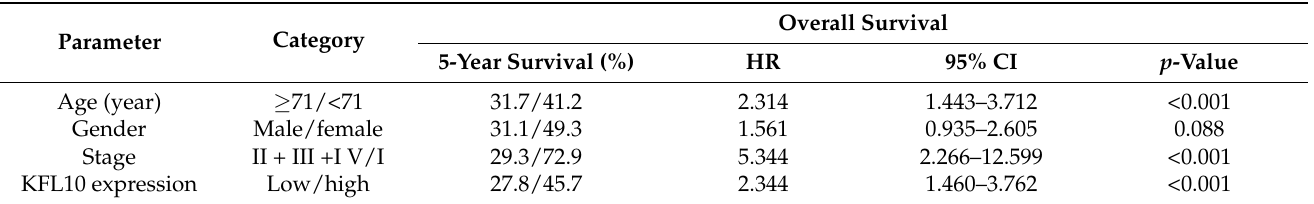
Table 3. Multivariate analysis of the influence of various parameters on overall survival in 121 gastric cancer patients.